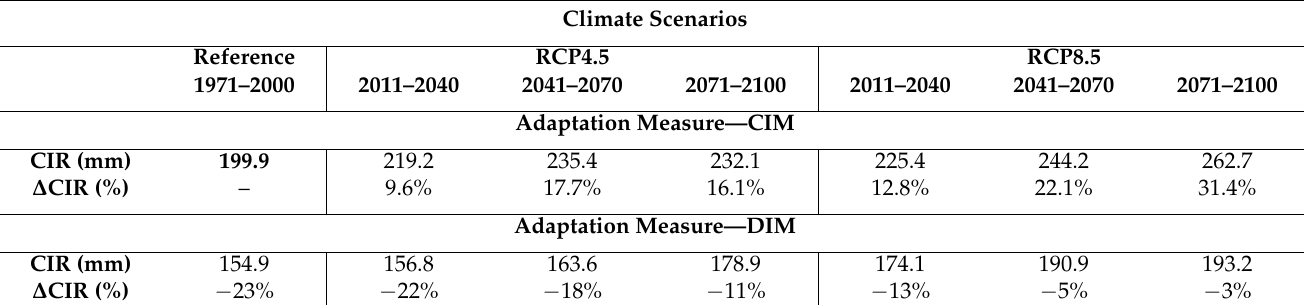
Table 7. Average seasonal crop irrigation requirements and respective variations, relative to the reference period considering the current irrigation strategy, for each CC scenario and adaptation